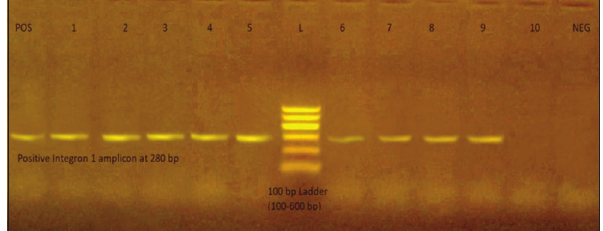
Figure-2: From the left to the right: POS: Positive integron 1 control at 280 bp, Lanes from (1-9): Specific amplicon at 280 bp, Lane L: 100 bp ladder (100-600 bp), Lane (10): Negative result no amplicon.